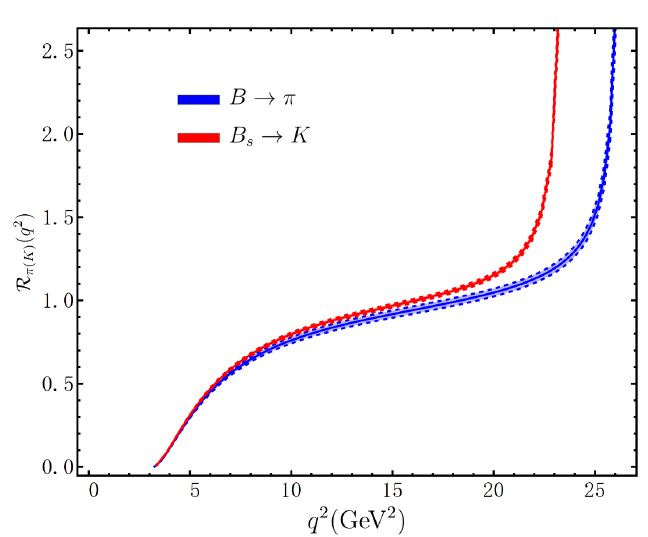
of the differential π ( K )